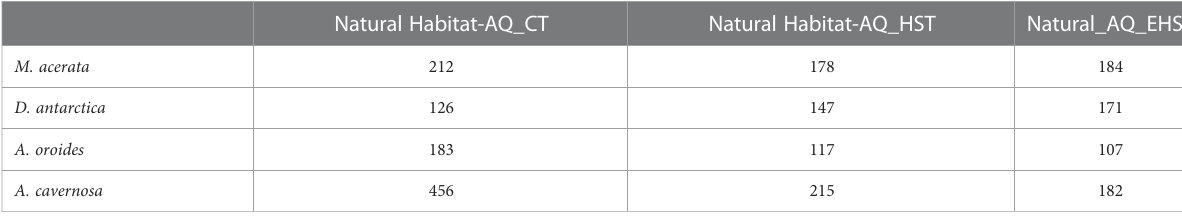
TABLE 4 Number of ASVs shared between natural habitat sponge specimens and those from aquaria exposed to control temperature (CT), heat stress temperature (HST) and extreme heat stress temperature (EHST) in the different sponge species. Natural